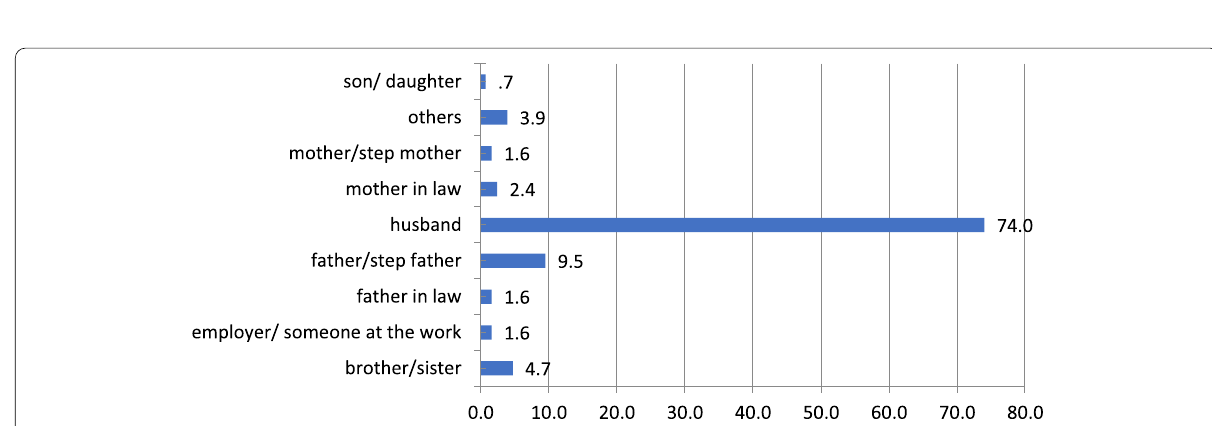
Fig. 2 Percentage of the persons who committed the violence against study participants ( n